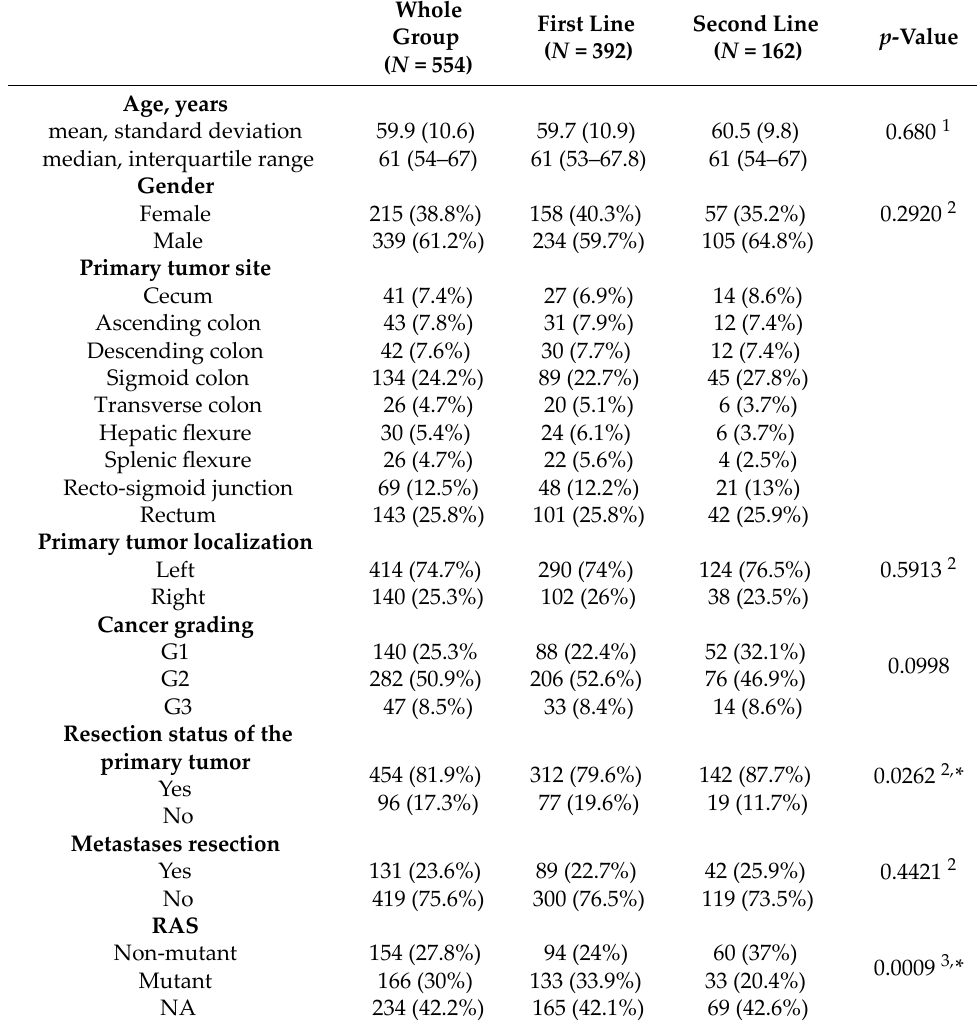
Table 1. Patients and disease characteristics ( N = 554).